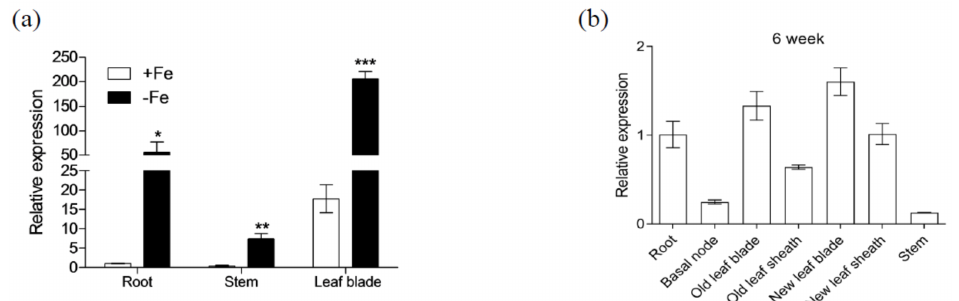
Figure 1. Expression pattern of OsIRO3. ( a ) Relative expression of OsIRO3 in root, stem, and leaf blade under both Fe-su ffi cient conditions ( + Fe) or Fe-deficient conditions ( − Fe). Two-week-old plants were transferred to + Fe or − Fe for 7 d. The root, leaf blades, and stems were sampled for expression analysis. Asterisks above bars indicate significant di ff erences (* p < 0.05, ** p < 0.01, *** p < 0.001) compared with the Fe-su ffi cient condition ( + Fe), as determined by two-tailed Student’s t test. ( b ) Relative expression of OsIRO3 in di ff erent organs at vegetative growth stage. Di ff erent tissues of 6–week-old rice grown in solution were sampled for expression analysis. The expression level relative to the expression in + Fe root ( a ) or root ( b ) was shown. Data are given as the means ± SD of three biological